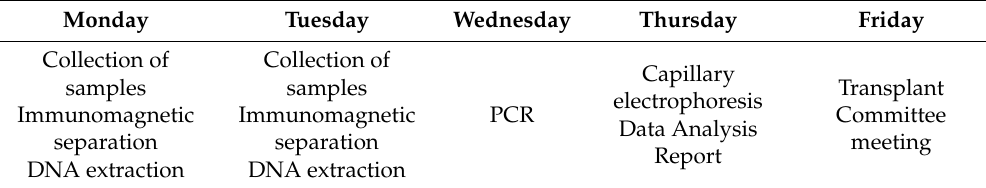
Table 5. Week workflow for STR-PCR